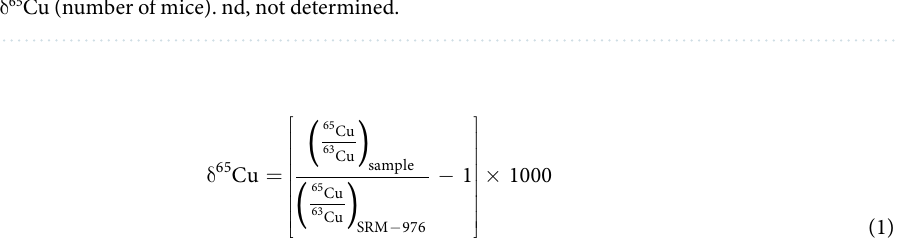
Table 1. Average isotopic composition of brain and serum samples. Numbers indicated correspond to mean + / − SD of δ 65 Cu (number of mice). nd, not